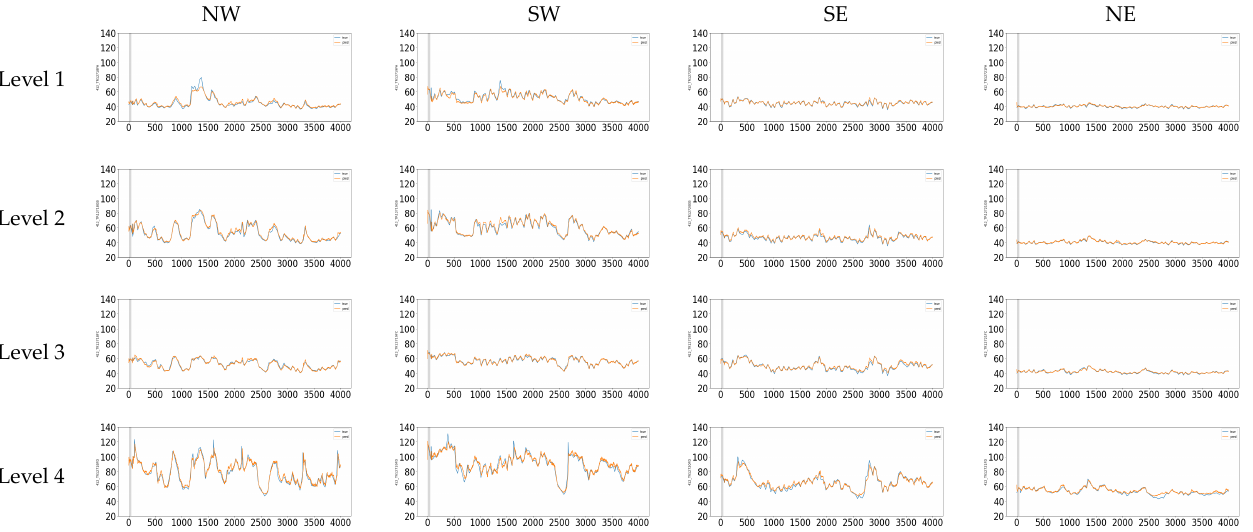
Figure 15. True and predicted behavior in each one of the 16 thermocouples studied in the test